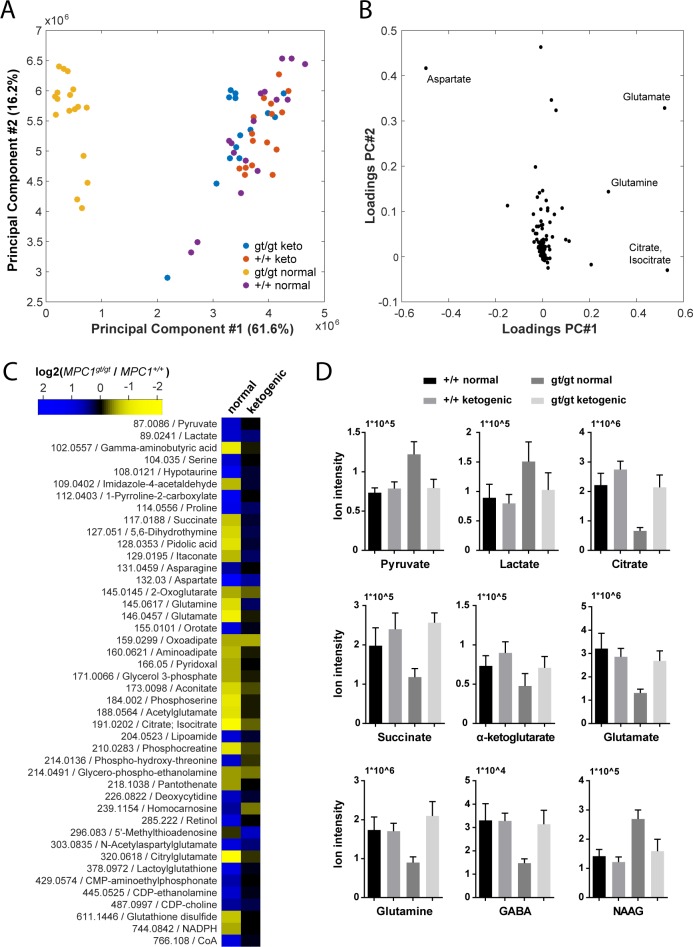
Pleiotropic alterations in the MPC1gt/gt E13.5 brain metabolome are rescued by a ketogenic diet.(A) Principal component analysis of brain metabolome data from E13.5 MPC1+/+ and MPC1gt/gt embryos from females maintained on normal or ketogenic (keto) diet and (B) underlying annotated metabolites showing highest variance among principal components. (C) Heat map showing fold changes of annotated metabolites (m/z is indicated) that were found to be significantly different (q-value < 0.01, abs(log2(fold change)) > 0.5) between MPC1gt/gt and MPC1+/+ brain samples from E13.5 embryos maintained on normal or ketogenic diets. (D) The abundance of the indicated metabolites in the brains of E13.5 MPC1+/+ or MPC1gt/gt embryos under normal or ketogenic diet was determined by non-targeted metabolomics.